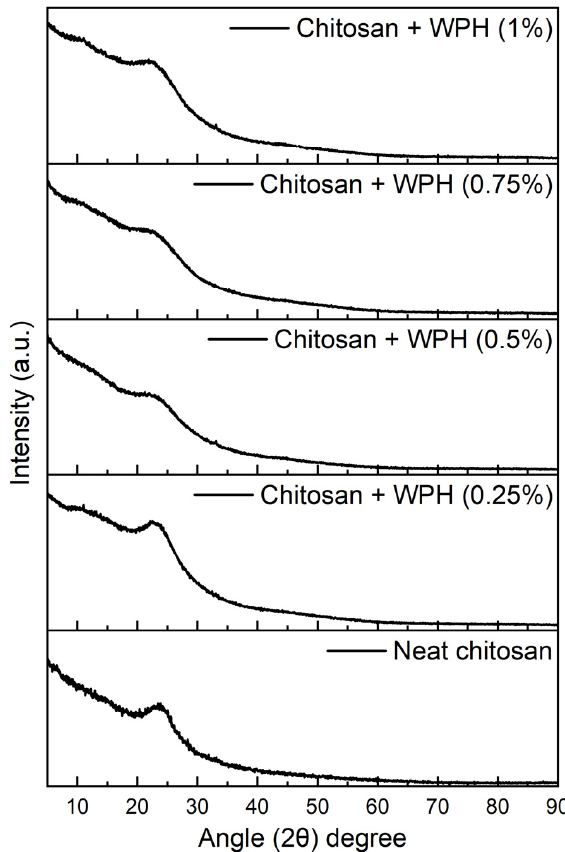
Figure 7. XRD analysis of chitosan/WPH films containing different concentrations of WPH showing amorphous nature of nanocomposites.